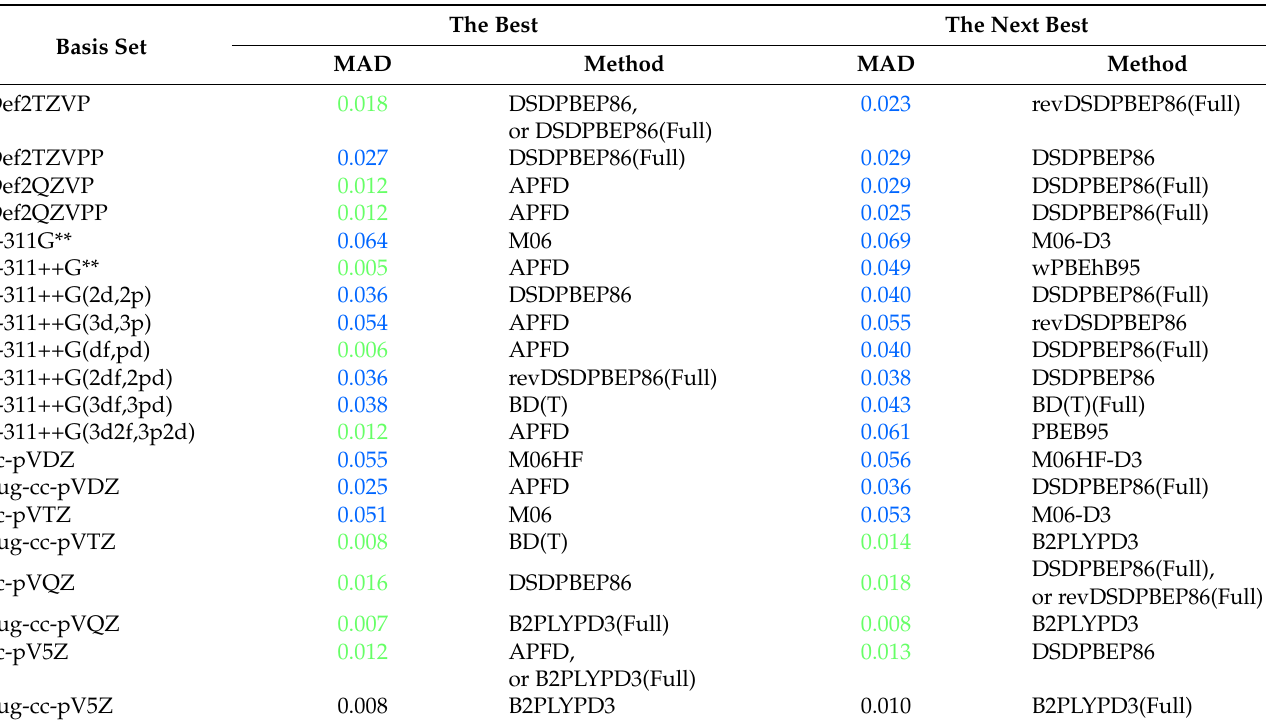
Table 2. The best and next best MADs (Å) and methods for the 20 basis